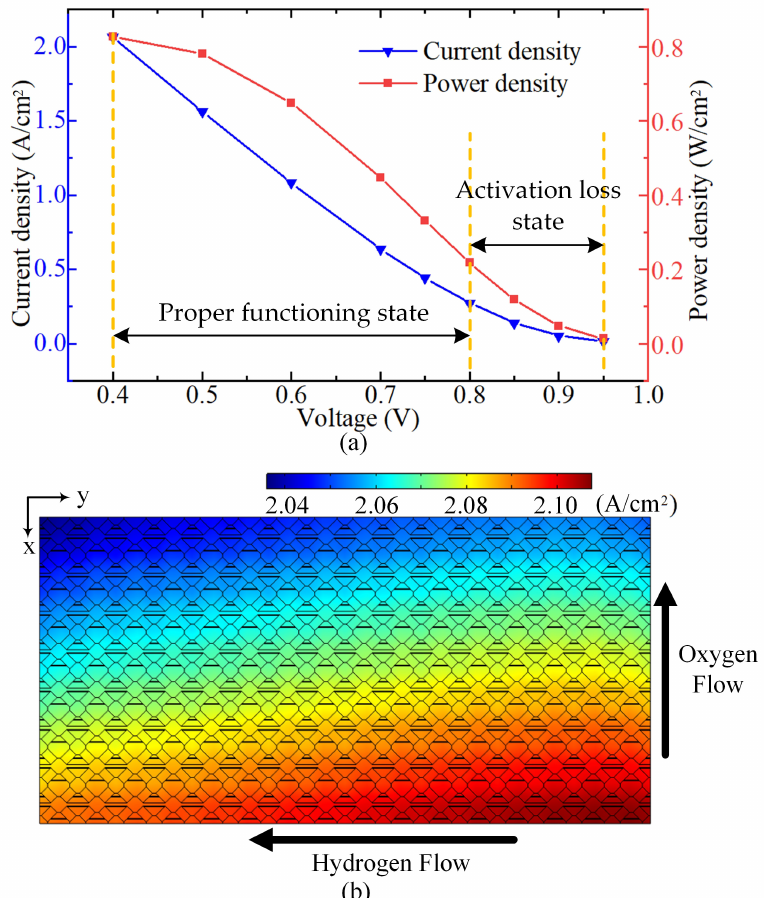
Figure 6. ( a ) Polarization and power density curve of PEMFC with 3D bionic flow field, ( b ) electro- chemical reaction current density.